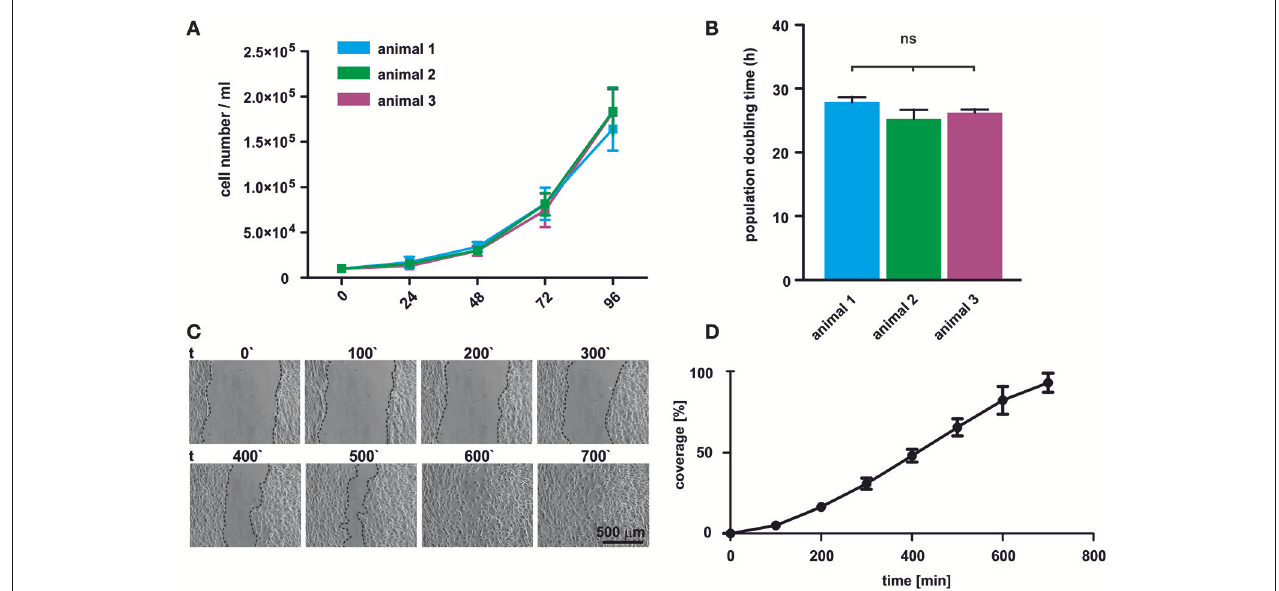
FIGURE 3 | oNCSCs are highly proliferative and migrate in vitro . (A) Total cell number was determined after 24, 48, 72, and 96h in adherent cultures of oNCSCs isolated from three different animals revealing normal exponential growth. (B) No significant differences in the population doubling time was observed between different oNCSC isolations. (C) In vitro wound healing assay was performed to assess the migratory potential of oNCSCs. Representative images are shown. Scale bar: 500 µ m. (D) Scratch coverage was assessed over time. Full coverage was achieved between 9 and 11h. All data are presented as mean ± SEM from three independent experiments.